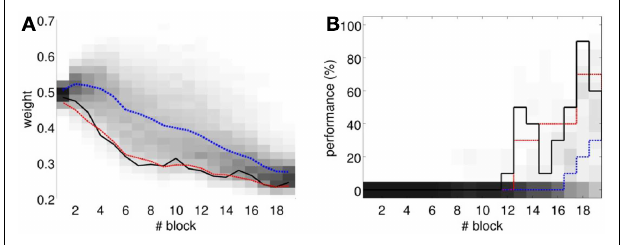
FIGURE 15 | Observed performance vs. performance during simulated unpaired acquisition. (A) Acquisition during paired CS–US training versus simulated unpaired CS–US.Trajectory of the weight during the acquisition phase of the experiment (black line) plotted against results of 20,000 simulations of unpaired training. Distribution of the simulation results (grayscale), median (blue dotted line), and the 0.05 bottom of the distribution (red line) is shown. Blocks of 10 trials. (B) Behavioral performance during acquisition against performance in the simulations. Percentage of CRs during acquisition in the experiment (black line) plotted against the percentage obtained in the simulations. Distribution of the simulation performances (grayscale), median (blue dotted), and the upper 0.1 of the distribution (red